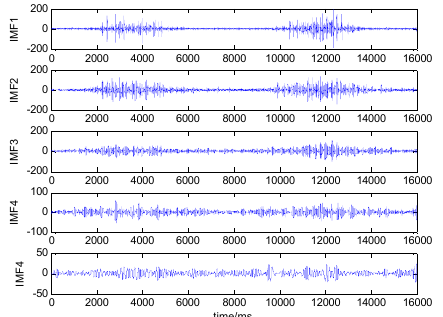
Figure 10. The original surface electromyography (sEMG) signal of the vastus medialis (VM). The abscissa is the number of signal points, and the ordinate is the signal amplitude.